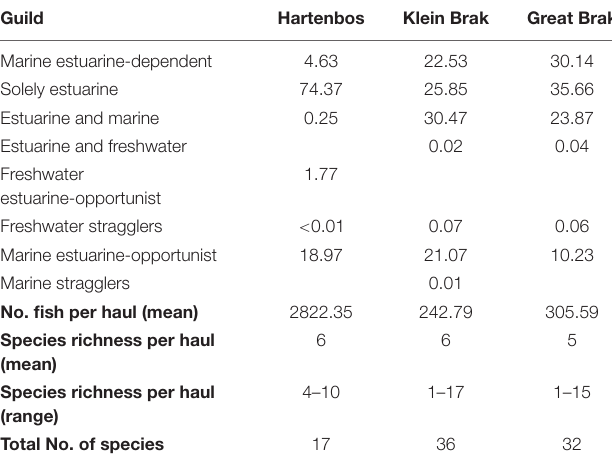
TABLE 3 | Fish guild composition and abundance (%) in the Hartenbos and nearby Klein Brak and Great Brak estuaries sampled over the same